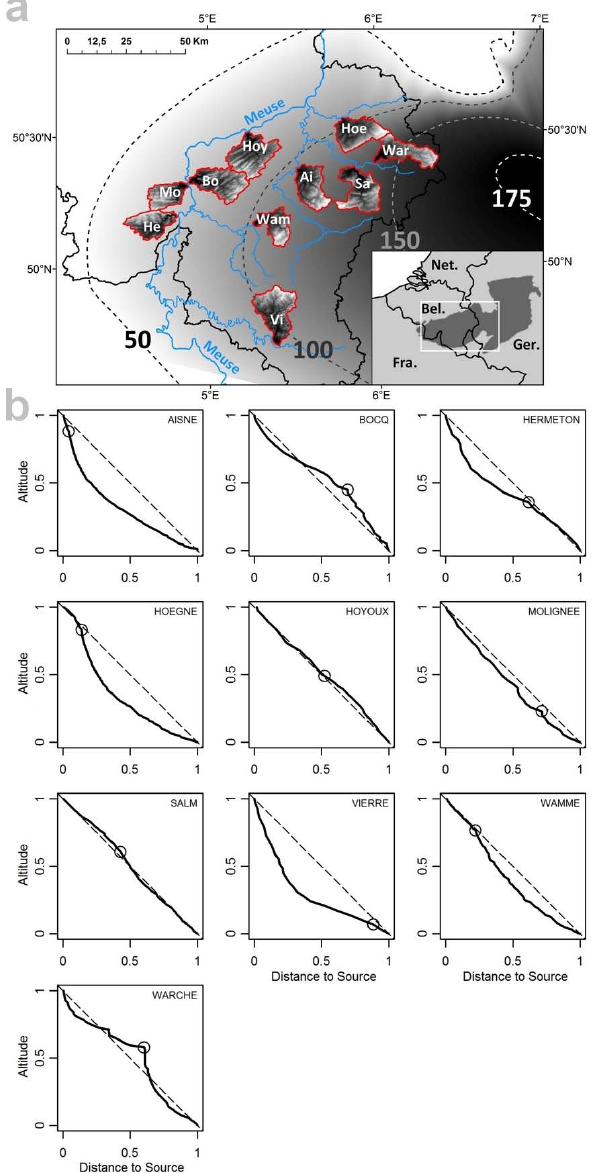
Fig. 1. (a) Location of the 10 catchments in the Ardennes-Rhenish Massif (inset map). The dotted lines correspond to the uplift iso- lines (values in meters) from Demoulin and Hallot (2009), and were derived from terrace sequences and planation surfaces. The names of the catchments are: Ai (Aisne), Bo (Bocq), He (Hermeton), Hoy (Hoyoux), Hoe (Hoegne), Mo (Molign´ee), Sa (Salm), Vi (Vierre), Wam (Wamme) and War (Warche). (b) Normalised longitudinal profiles of the 10 selected rivers with location of the main channel convexity